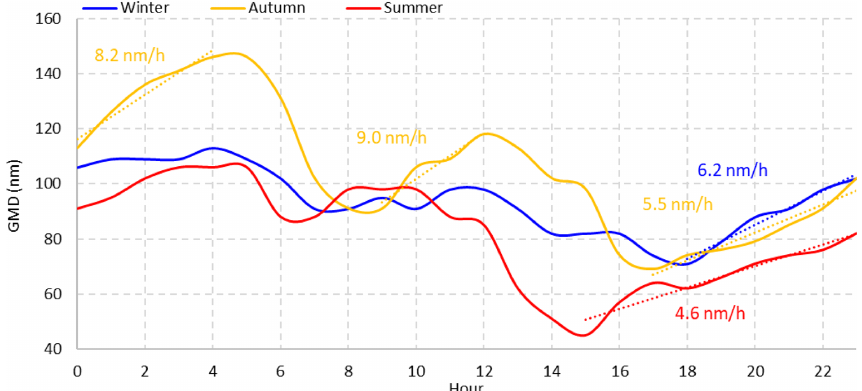
Figure 8. Diurnal change in the geometric mean diameter (GMD) calculated for winter, autumn and summer seasons. Growth rates (nm/h) are calculated from dGMD/d t